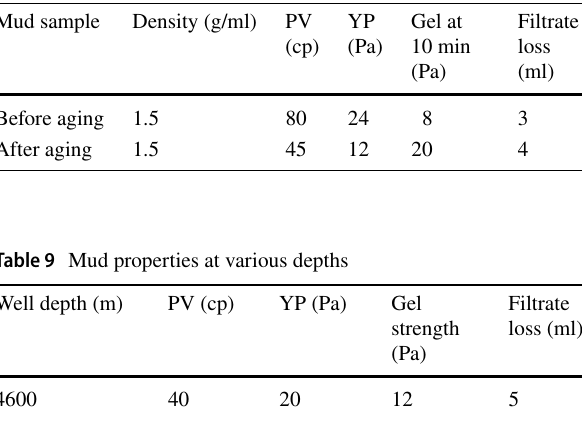
Table 11 Mud properties under effects of aging and calcium